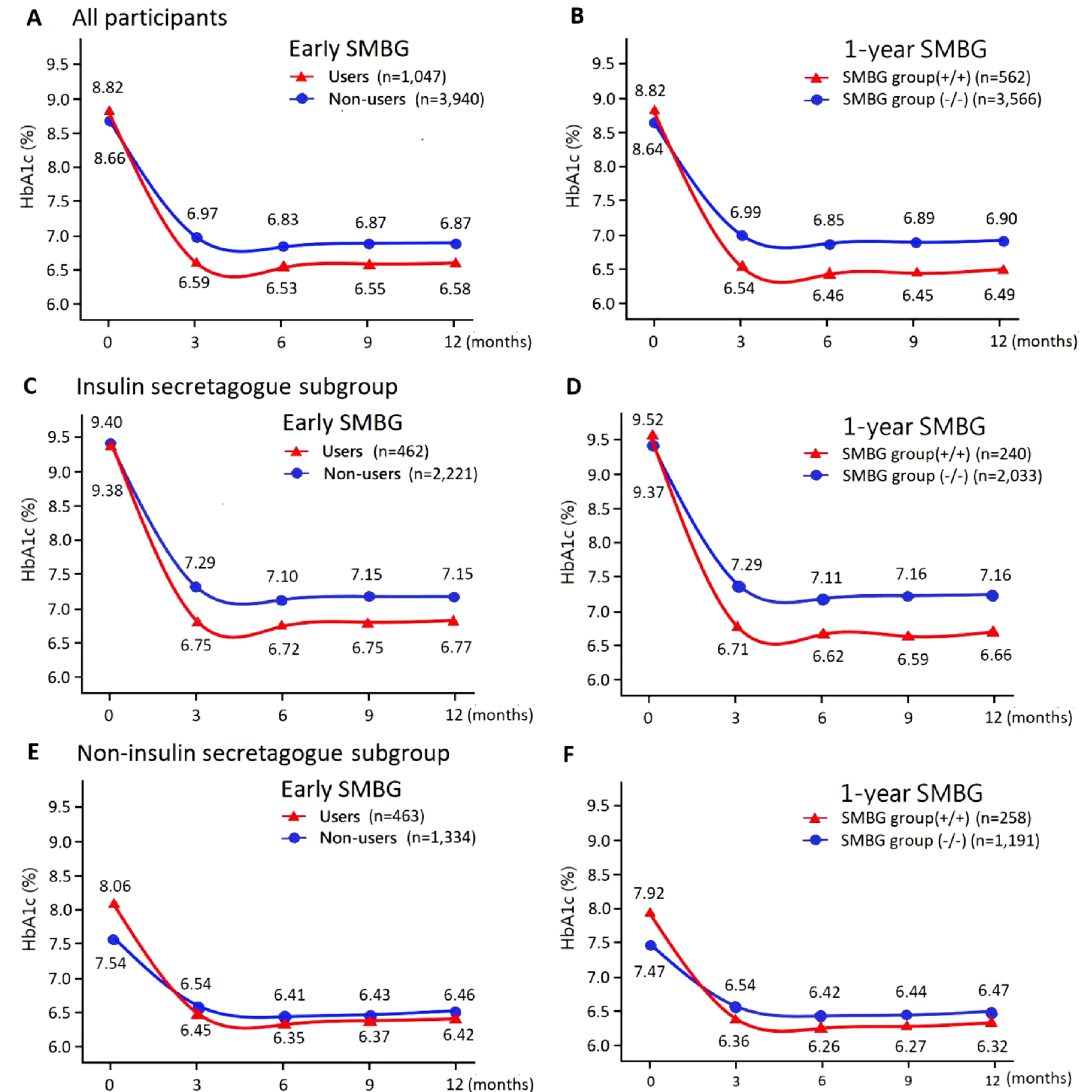
Figure 2. Model-based mean HbA1c values and longitudinal HbA1c trajectory after adjustment of confounding variables by generalized estimating equations: ( A ) Early SMBG, users: SMBG group (+/+,+/–) versus non-users: SMBG group (–/+, –/–), in all participants; ( B ) 1-years SMBG, SMBG group (+/+) versus SMBG group (–/–), in all participants; ( C ) Early SMBG, users versus non-users, in insulin secretagogues subgroup; ( D ) 1-years SMBG, SMBG group (+/+) versus SMBG group (–/–), in insulin secretagogues subgroup; ( E ) early SMBG, users vesus non-users, in non-insulin secretagogues subgroup; ( F ) 1-years SMBG, SMBG group (+/+) versus SMBG group (–/–), in non-insulin secretagogues subgroup. All the p-values of interaction terms of SMBG group and time were ≤ 0.002. Details are presented in Supplementary Table S1. SMBG, self- monitoring of blood glucose; HbA1c, hemoglobin